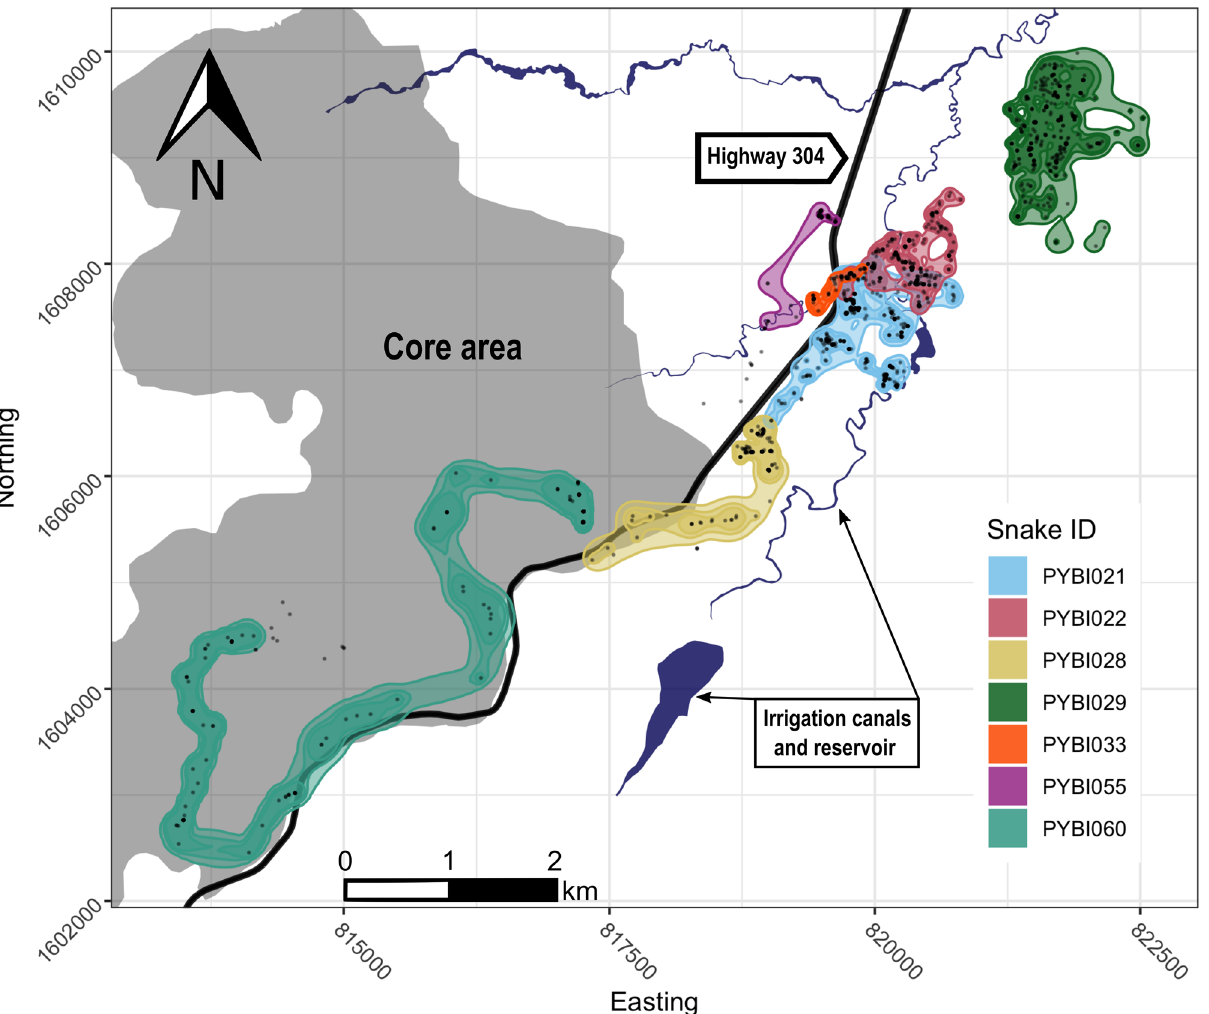
Figure 2. Dynamic Brownian Bridge Movement Models occurrence distributions (95% and 99% confidence areas) for radio-tracked Burmese pythons (Python bivittatus ) in the Sakaerat Biosphere Reserve, Nakhon Ratchasima, Thailand. Black points on the map denote snake locations from telemetry. Map created using R v.3.6.3 (https:// www.r- proje ct. org/) in RStudio v.1.2.1335 (https:// rstud io. com/) in combination with Inkscape v.1.0.2 (https:// inksc ape.